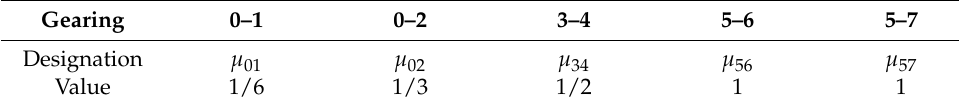
Table 2. Gears appearing in equations of motion.